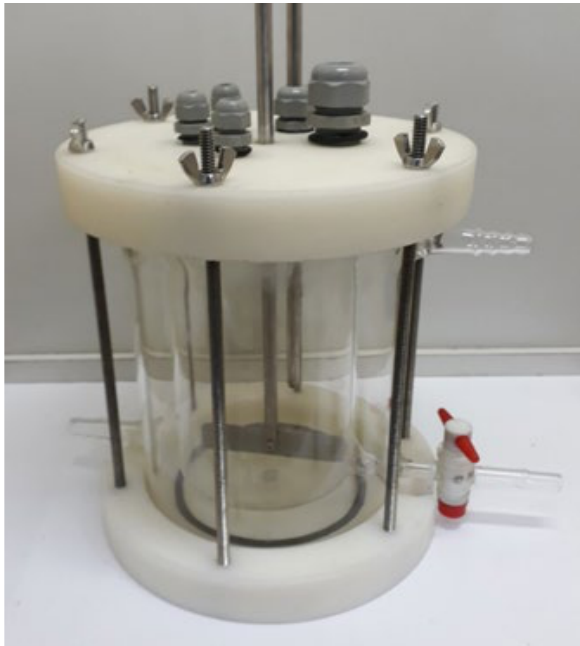
Figure 3. Complete jacketed bioreactor